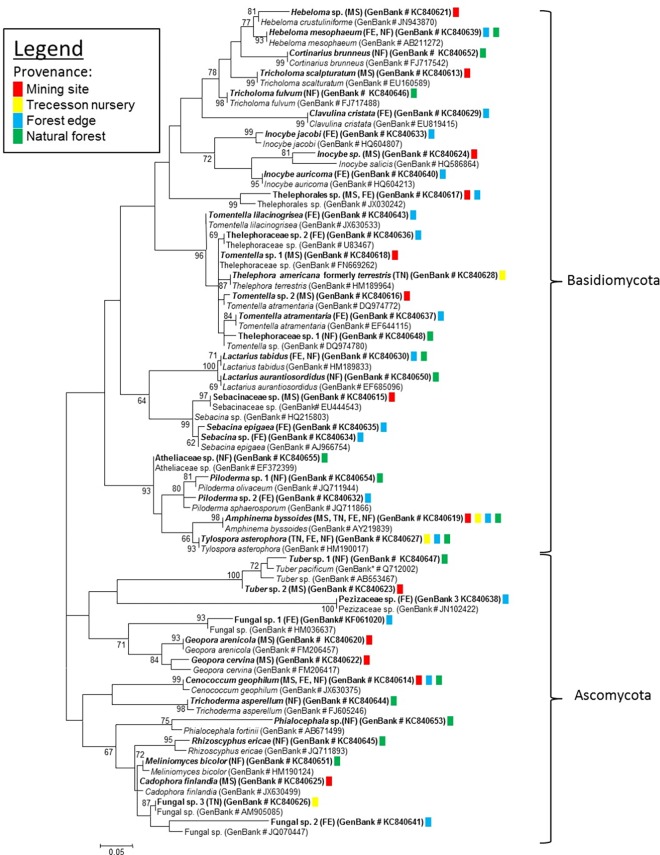
Phylogenetic tree containing all ECM fungal taxa (in bold) that have been identified on the four sites (mining site (MS) in red, Trecesson nursery (TN) in yellow, forest edge (FE) in turquoise, and natural forest (NF) in green) with their corresponding GenBank accession number–Taxa not in bold refer to the most similar blastn results and GenBank taxa used for ECM fungal species identification.